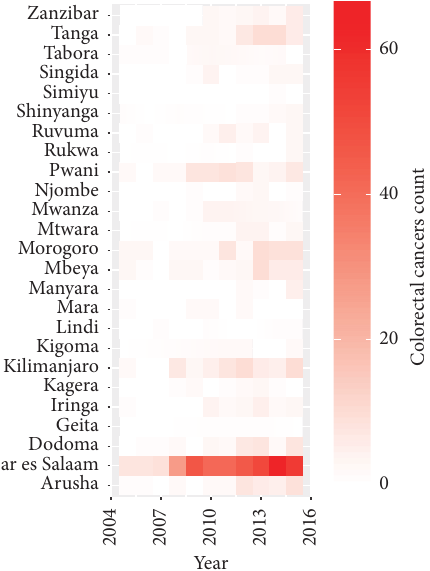
Figure 4: Colorectal cancer cases by region and year.